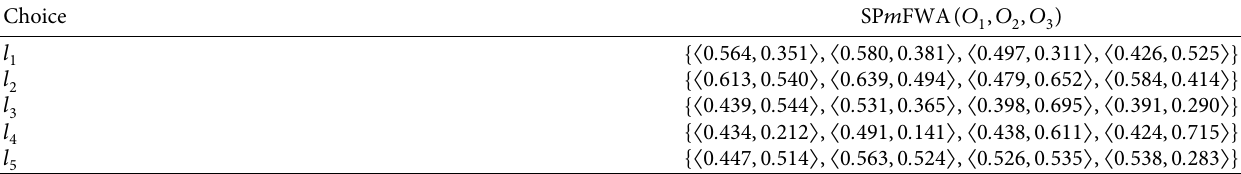
, O , O ) for each choice. 1 2 3